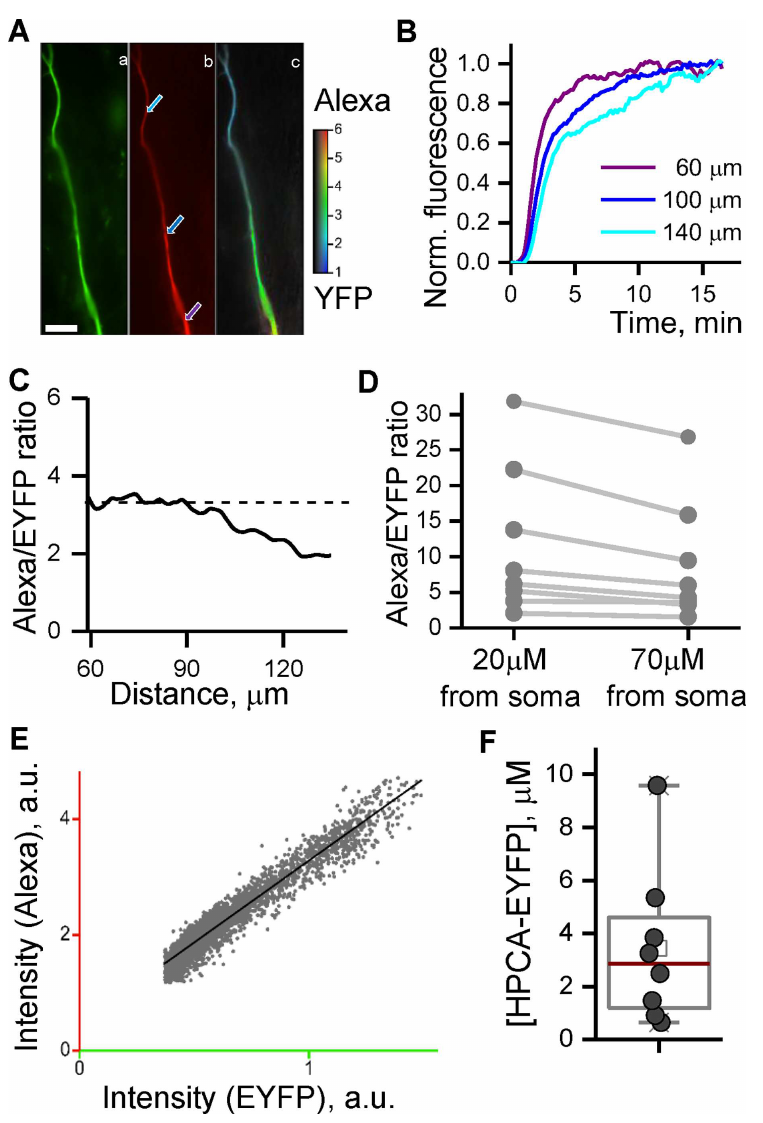
Fig 4. Estimation of HPCA-EYFP concentration in a dendritic tree of cultured hippocampal neurons. Hippocampal neurons (DIV 10–20) expressing HPCA-EYFP were patched with pipettes filled with an intracellular solution containing Alexa Fluor 594 dye (20–50 μM). (Aa) HPCA-YFP image of dendrite taken at the beginning of experiment, before the membrane rupture. (Ab). Alexa Fluor 594 image of the same area taken in 15 min after cell rupture. Analogous images were taken in other tested neurons and used for obtaining graphs shown in (D) and (F). Arrows denote regions of interest, ROIs, where the fluorescence intensity was measured; the corresponding time courses shown in (B). (Ac). A color-coded ratio of Alexa Fluor 594 to HPCA-YFP fluorescence intensities. Scale bar is 10μm. (B) Intensity of Alexa Fluor 594 fluorescence was measured over time at ROIs indicated by the arrows in (Ab). Intensity profiles are normalized by their maximal values. Colors of the traces correspond to the colors of the arrows in (Ab). (C) A ratio profile of Alexa Fluor 594 to HPCA-YFP fluorescence taken along the dendrite. The plot demonstrates a plateau region up to 100μm from soma where Alexa Fluor 594 wash-in was competed in 15 min after the membrane rupture thus far indicating a range of distances from soma where HPCA-EYFP concentration can be accurately estimated. (D) Ratios of Alexa Fluor 594-to-HPCA-EYFP fluorescence in the proximal and distal parts of the apical dendrites in 15 min after the membrane rupture for 8 tested neurons. The graph demonstrates substantial wash-in of Alexa Fluor 594 in the distal parts of dendrites. A ratio of Alexa/EYFP fluorescence in a distal part normalized to the same ratio in a proximal part was 0.75±0.04. (E) A correlation plot of HPCA-EYFP and Alexa Fluor 594 fluorescence intensities generated for all pixels in the dendrite corresponding to the plateau region in (C) (green region in (Ac)). A linear regression of this plot indicates to a significant linear correlation between HPCA-YFP to Alexa Fluor 594 fluorescence (R 2 = 0.87). (F) Estimated dendritic concentrations of HPCA-EYFP in the cytosol pulled from eight tested neurons.